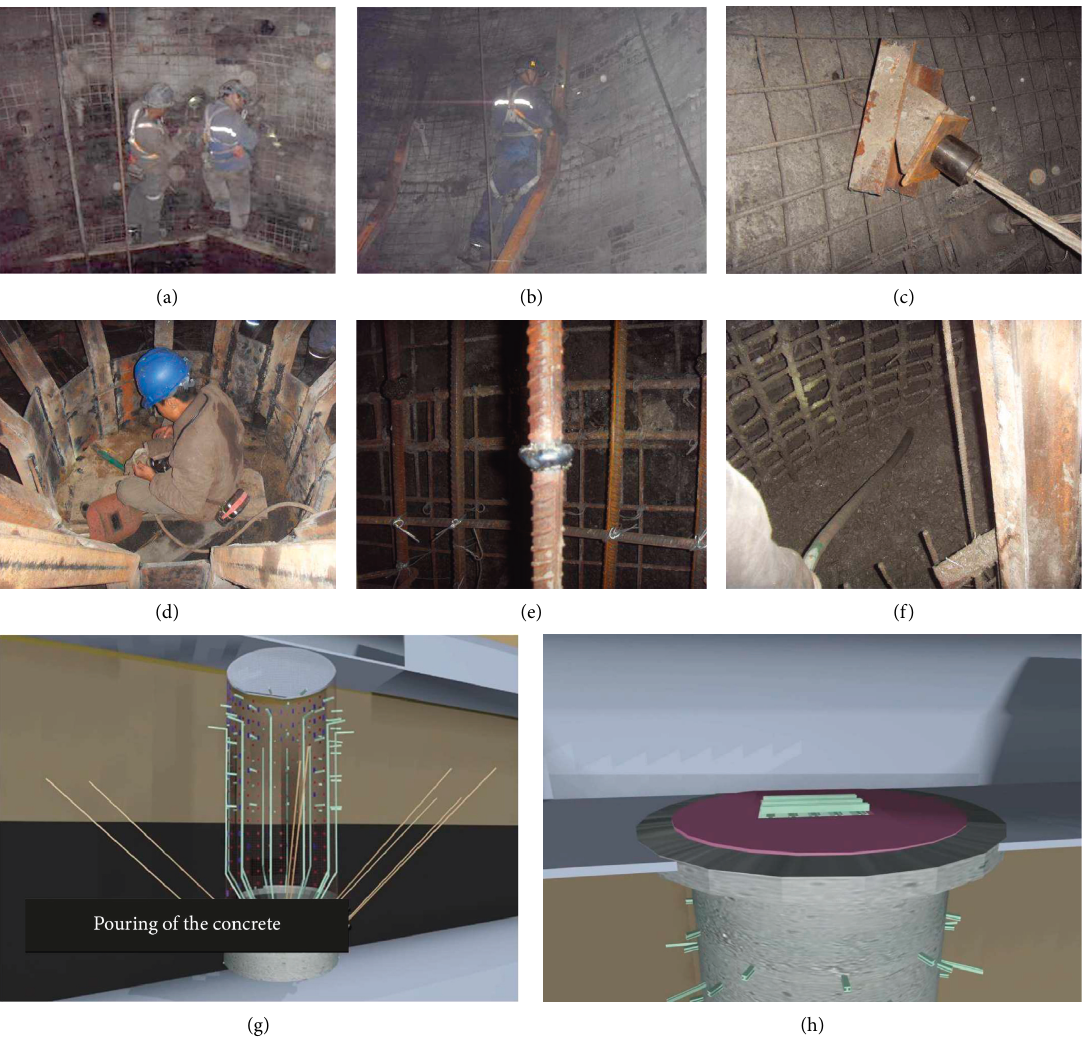
Figure 17: Construction procedures. (a) Installation of the bolt-mesh-cable system and the self-designed H-steel beams during stepwise excavation of the rocks, (b) installation of the self-designed H-steel brackets, (c) installation of the self-locking anchor cables, (d) fitting the bottom parts of H-steel brackets together to form the skeleton of the coal hopper, (e) configuring rebars around the bunker, (f) pouring concrete and (g) that was vibrated to remove any entrapped air bubbles, and (h) installation of related components at the top of the